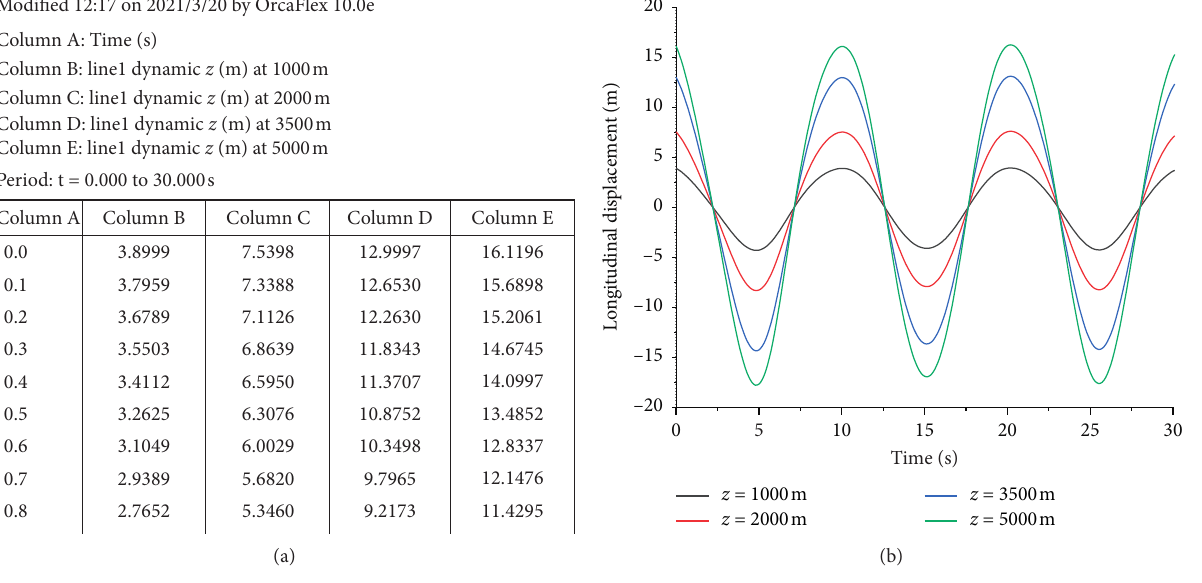
Figure 6: Simulation results of longitudinal vibration displacement based on Orcaflex: (a) calculation results and (b) longitudinal vibration